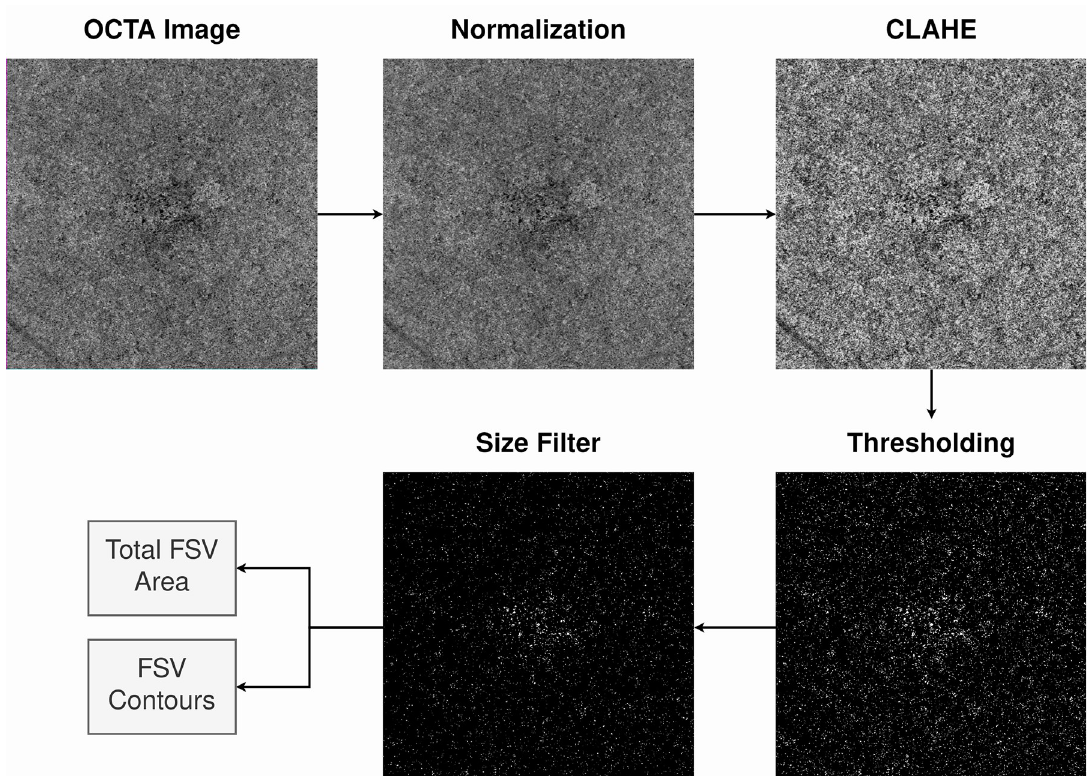
Fig 4. Diagram showing the different steps of this image-processing